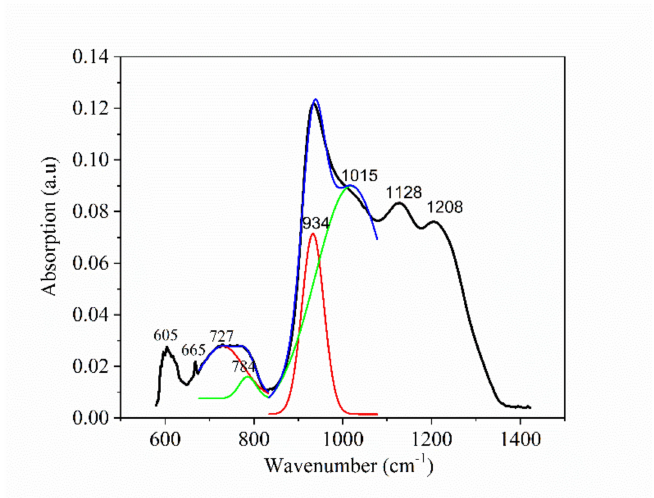
Figure 6. FTIR spectrum of the Te-5 glass